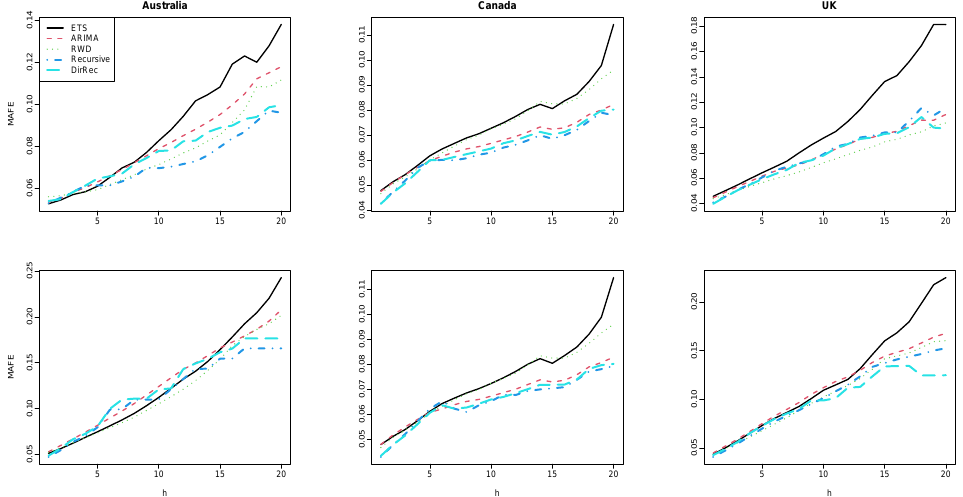
Figure 3. Computed MAFE values of log mortality rates for Australia ( first column ), Canada ( second column ), and UK ( third column ). The results for the female group are given in the first row while the results for the male group are given in the second